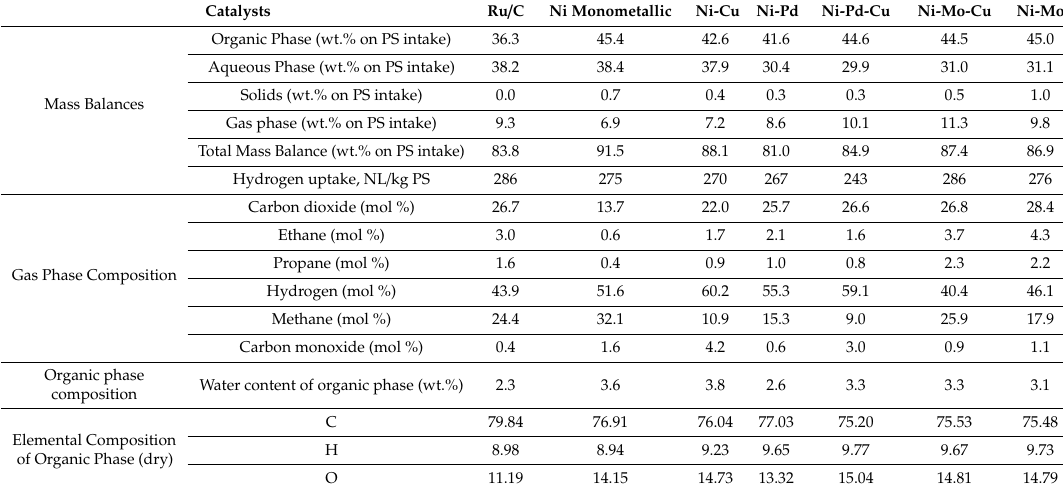
Table 4. Overview of the experiments for the catalytic hydrotreatment of PS. Catalysts